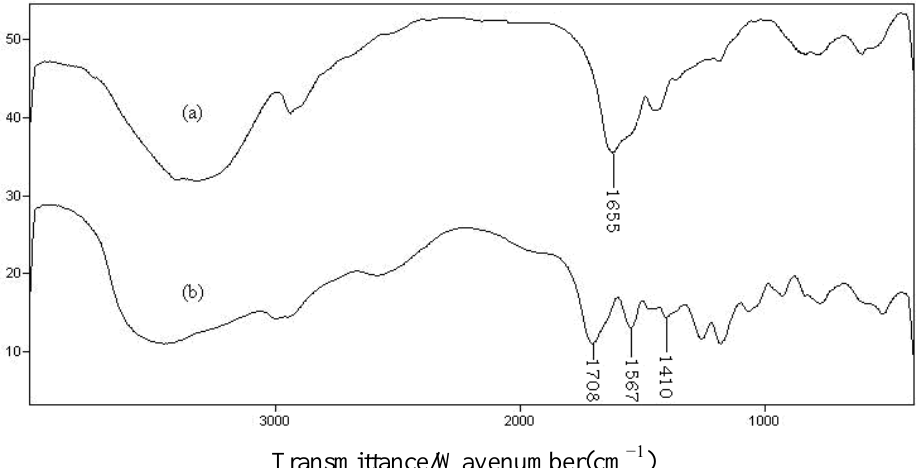
Figure 3. FTIR spectra of hydrolyzed gelatin (a) and gelatin-g-PMAA hydrogel (b)